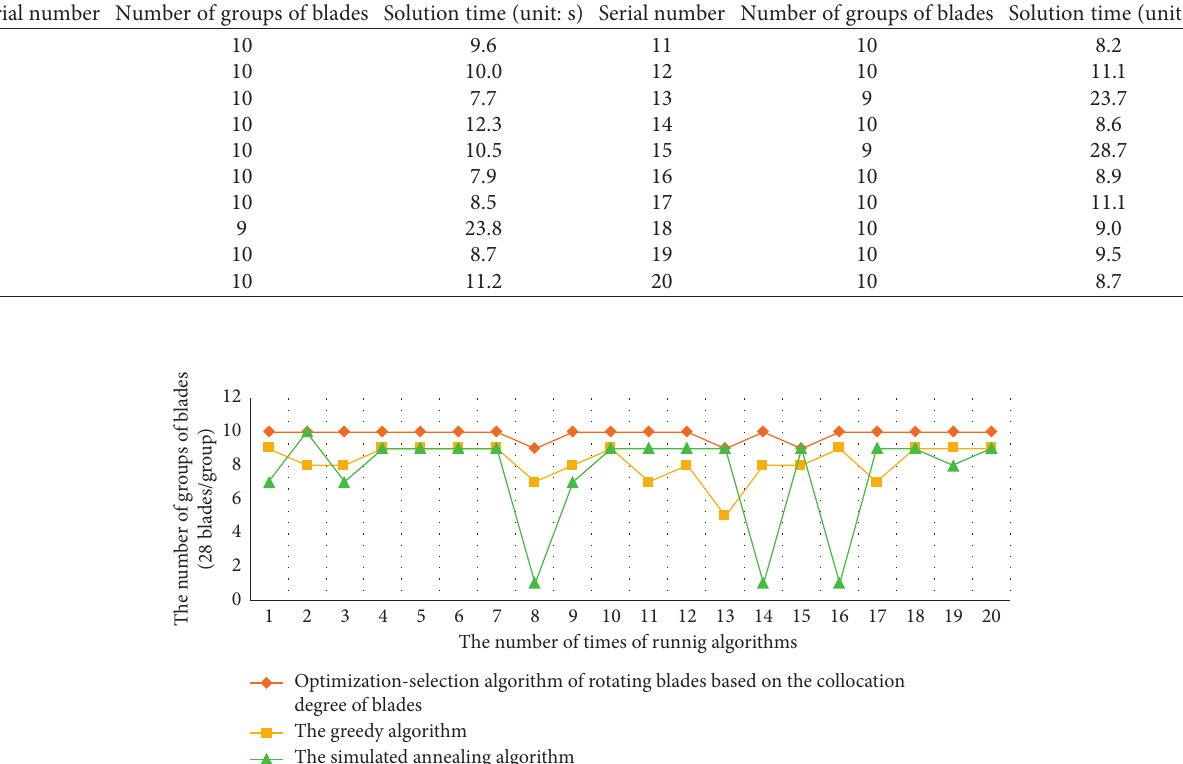
Figure 6: Comparison of solution results of the three algorithms.